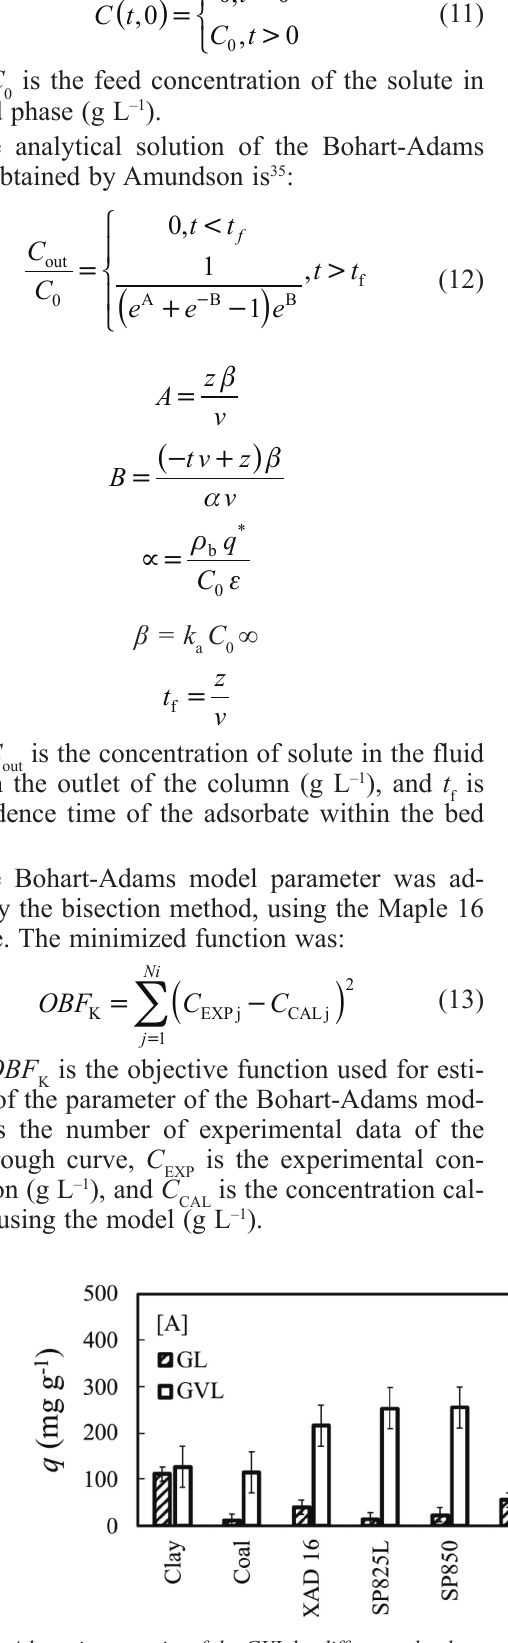
Fig. 1 – Adsorptive capacity of the GVL by different adsorbents. [A] 24 g L –1 GVL and 66 g L –1 GL; [B] 12 g L –1 GVL and 33 g L –1